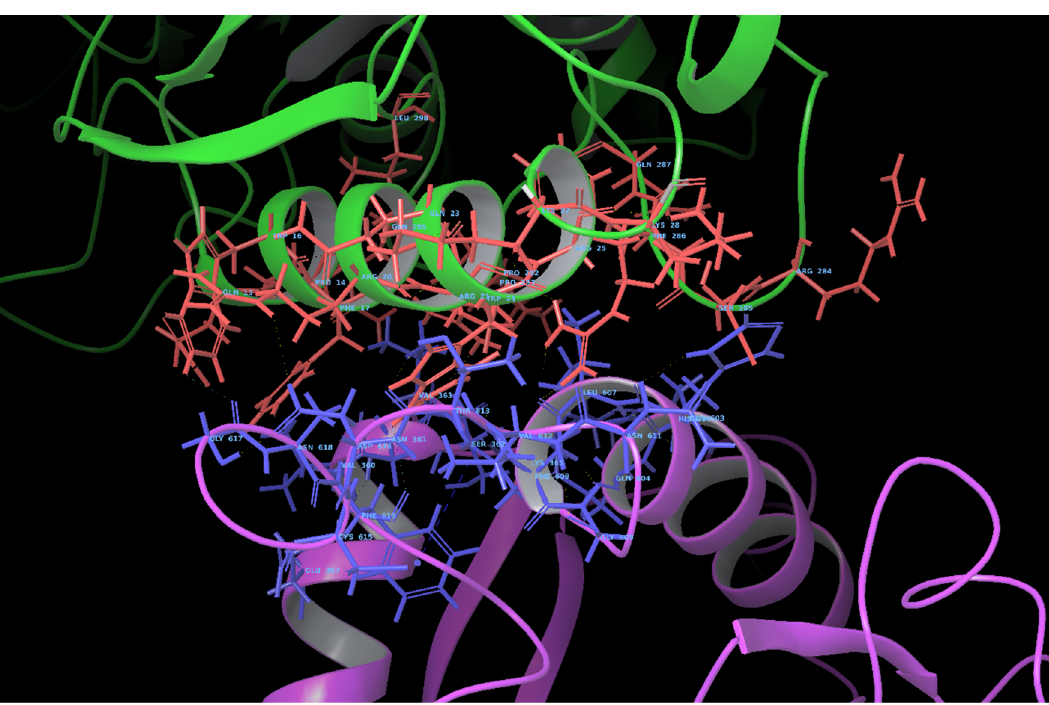
Figure 3. MD Simulation Image between Tf (protein in green with amino acids in red) and Lf (protein in purple with amino acids in blue).